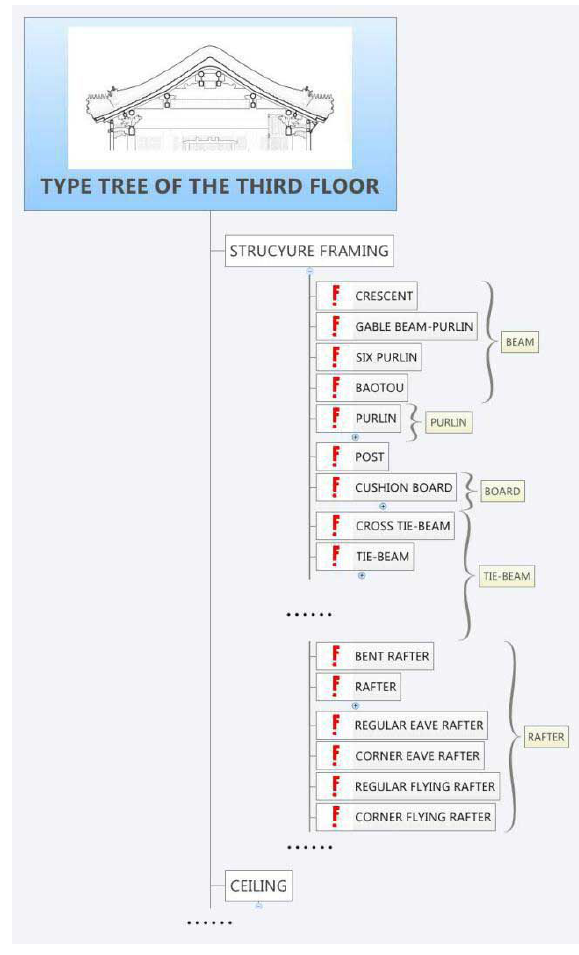
Figure 8. The hierarchical structure